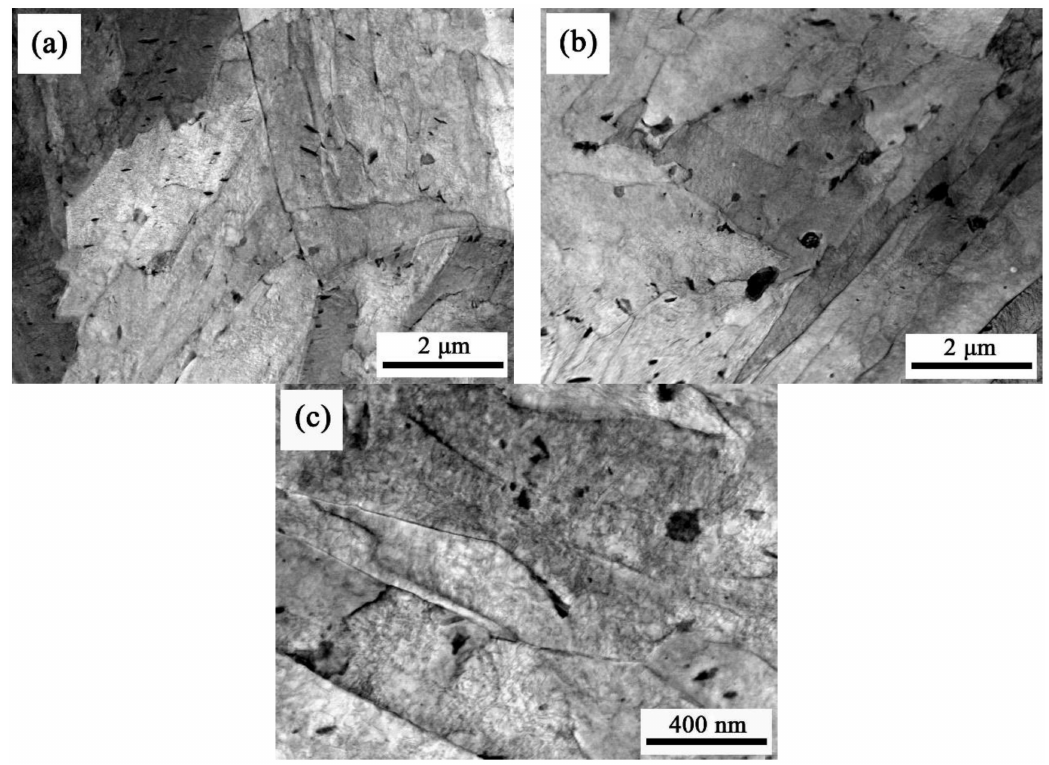
Figure 15. TEM micrograph ( a ), ( b ) and ( c ) showing the CGHAZ microstructure of sample